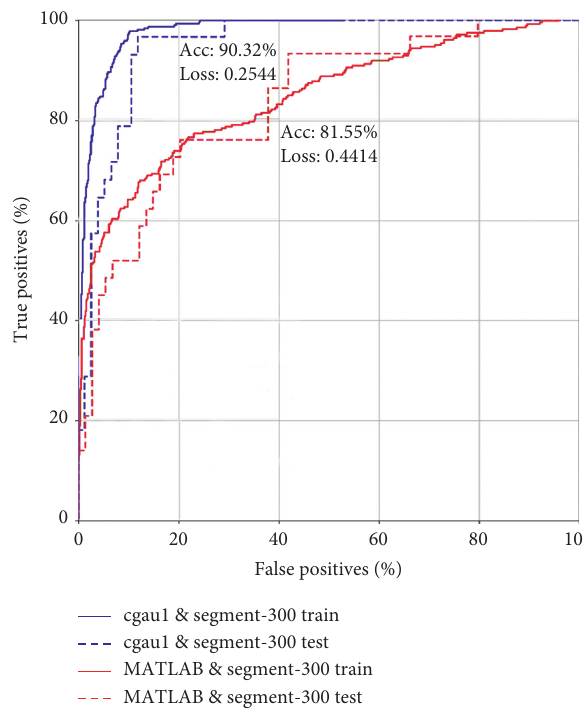
Figure 6: The accuracy of cgau1 and segment-300 and MATLAB scalogram and segment-300 in our proposed CNN from the re- ceiver-operating characteristic